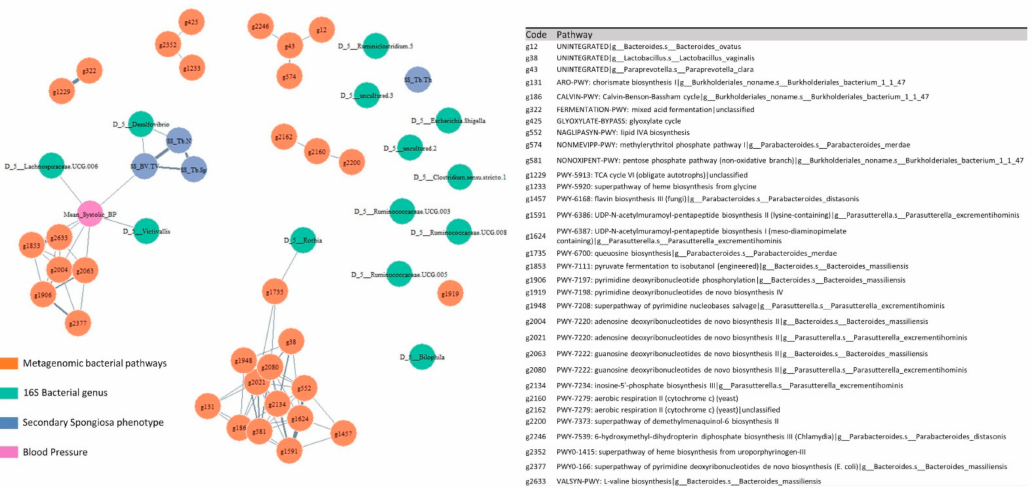
Figure 7. Multi-omics correlation networks between the selected metagenomic bacterial pathways, 16S bacterial genus, phenotypes secondary spongiosa, and blood pressure of all experimental groups. The nodes are colored in orange for the pathways enriched from metagenomic data, cyan for bacterial genus identified from 16S rRNA Gene Sequencing, blue for secondary spongiosa phenotype, and pink for blood pressure. The edges of the networks are defined by Spearman’s correlation coefficients with Benjamini and Yekutieli-adjusted p -value < 0.05. Greater intensity and thickness of the edges represent the higher strength of the correlation. An index is shown on the right for the mapping between the enriched bacterial pathways and their corresponding